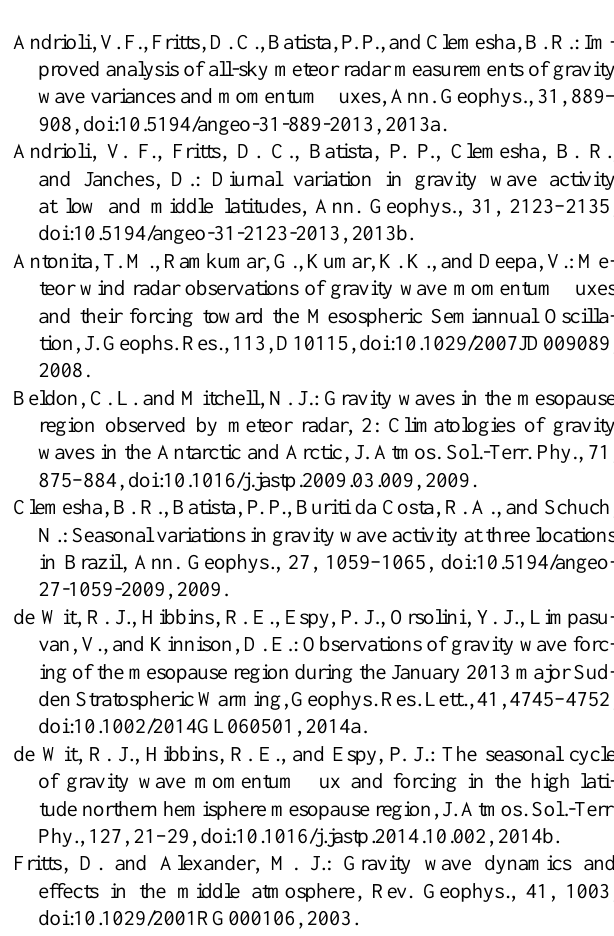
Figure 12. The same as Fig. 11 but for the meridional momentum flux